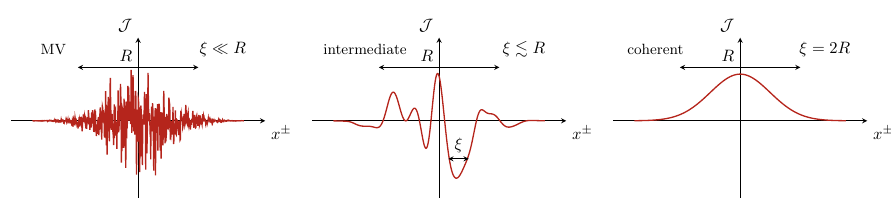
Figure 2. A sketch of the color current in various limits of the 3 + 1 dimensional MV model. The ratio of the longitudinal width R and the longitudinal correlation length ξ determines the non-trivial structure of the nuclei. For ξ/ R → 0 (left panel) the correlator reduces to the usual MV model. The coherent limit is reached by choosing the correlation length to be as large as the system ( ξ = 2 R , right panel). The longitudinal structure of realistic high energy nuclei is most likely described by ξ (cid:2) R for not too small ξ (center